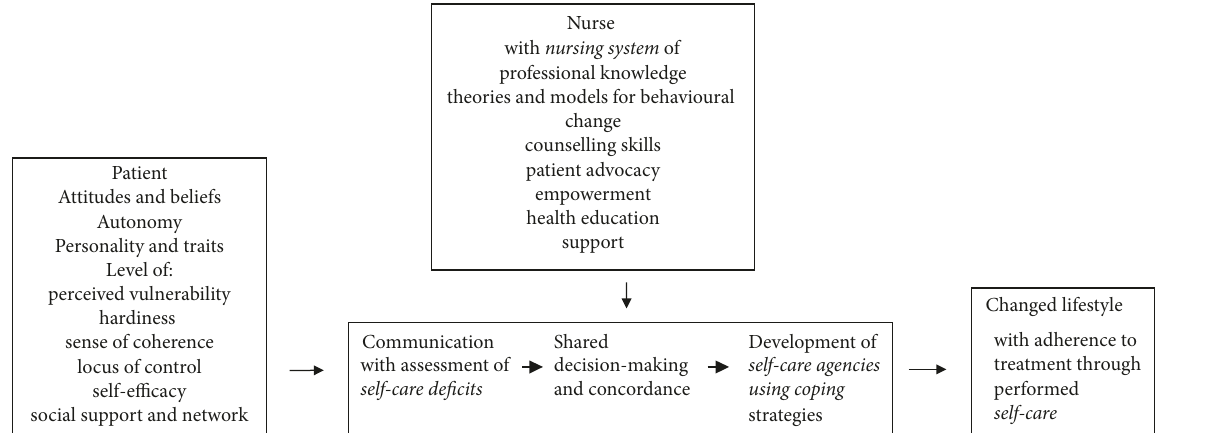
Figure 1: The constructed middle-range theory for nursing management of patients in hypertension care with the concepts involved in counselling about lifestyle changes and Orem’s self-care deficit theory of nursing applied (shown in italics).